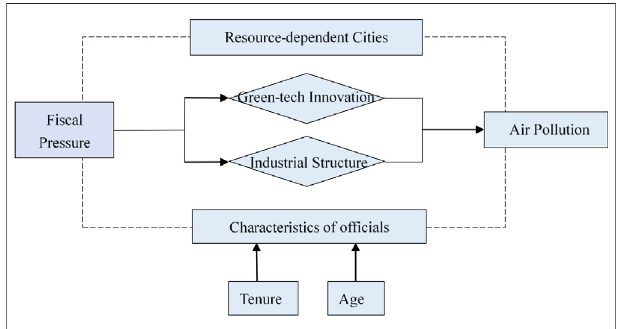
FIGURE 4 | Pathways of fi nancial pressure